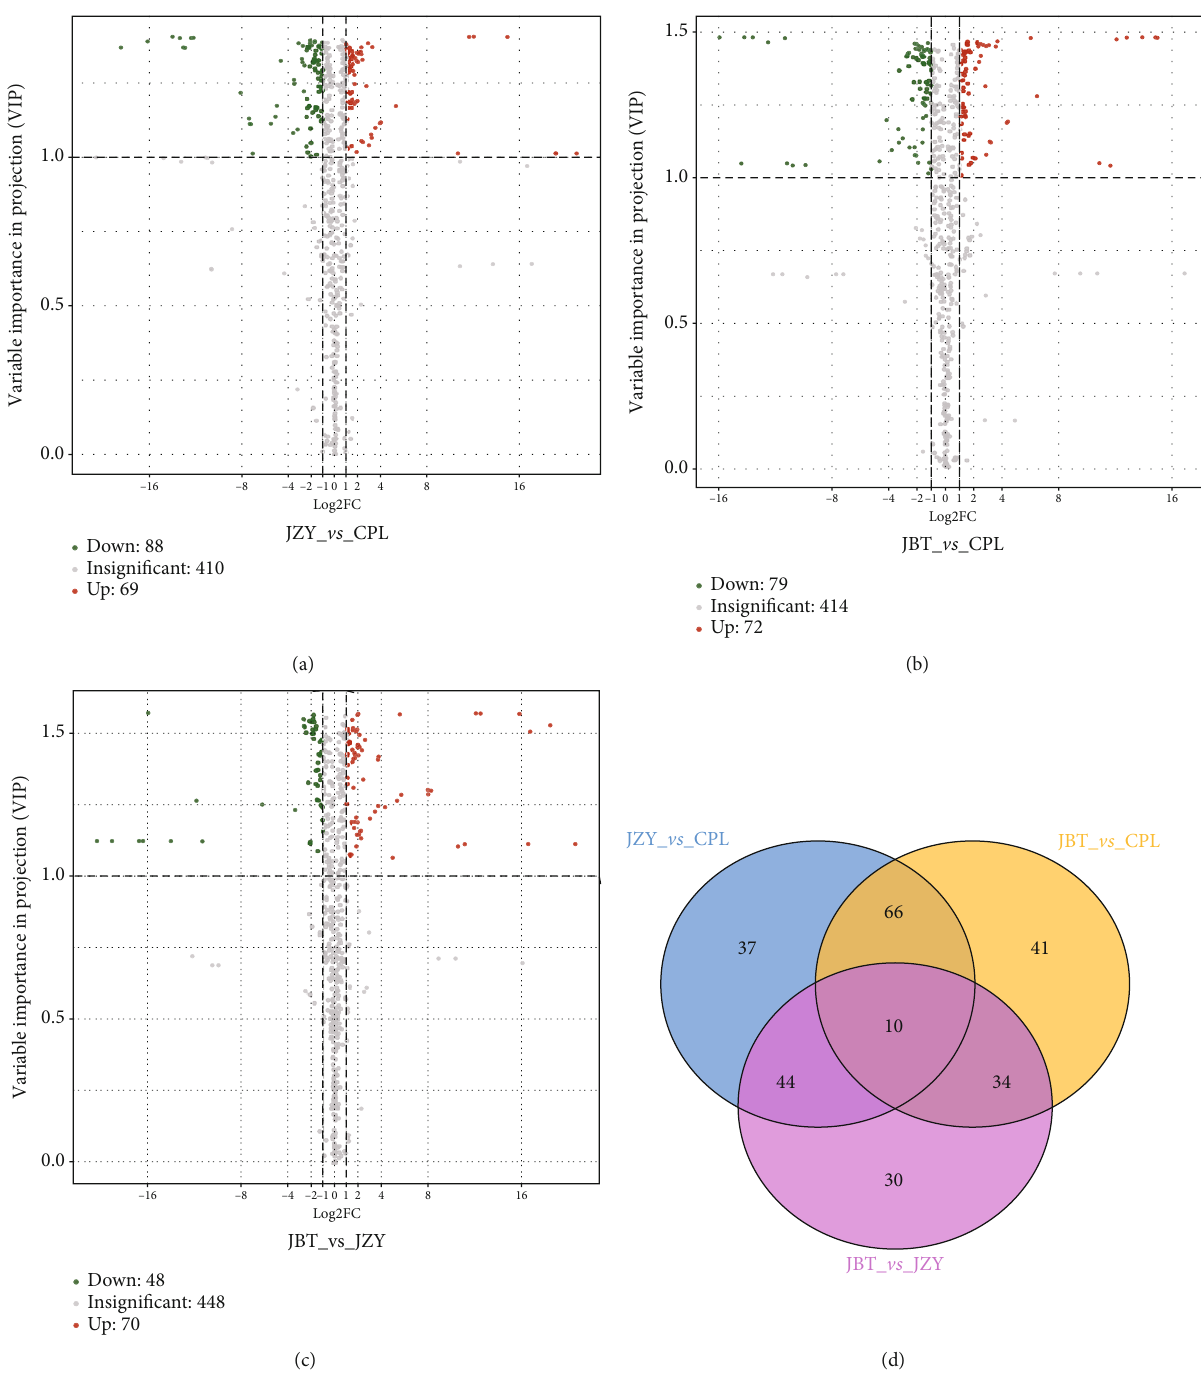
Figure 3: Di ff erential metabolites in pairwise comparison among the sweet corn cultivars: (a) volcanic plots of di ff erential metabolites in JZY vs. CPL; (b) volcanic plots of di ff erential metabolites in JBT vs. CPL; (c) volcanic plots of di ff erential metabolites in JBT vs. JZY; (d) overlap of di ff erentially expressed metabolites in sweet corn kernels ( VIP > 1 ). The number in each subcollection refers to quantity of metabolites in